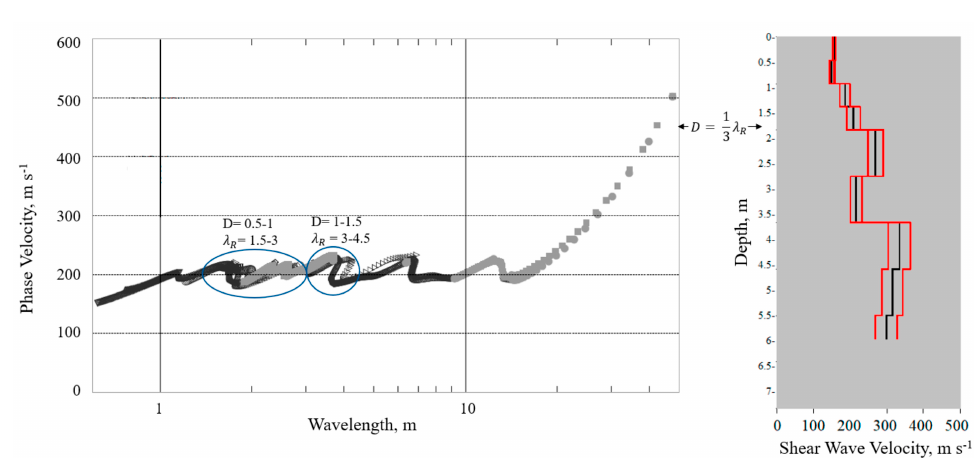
Figure 11. Dataset preparation for ML